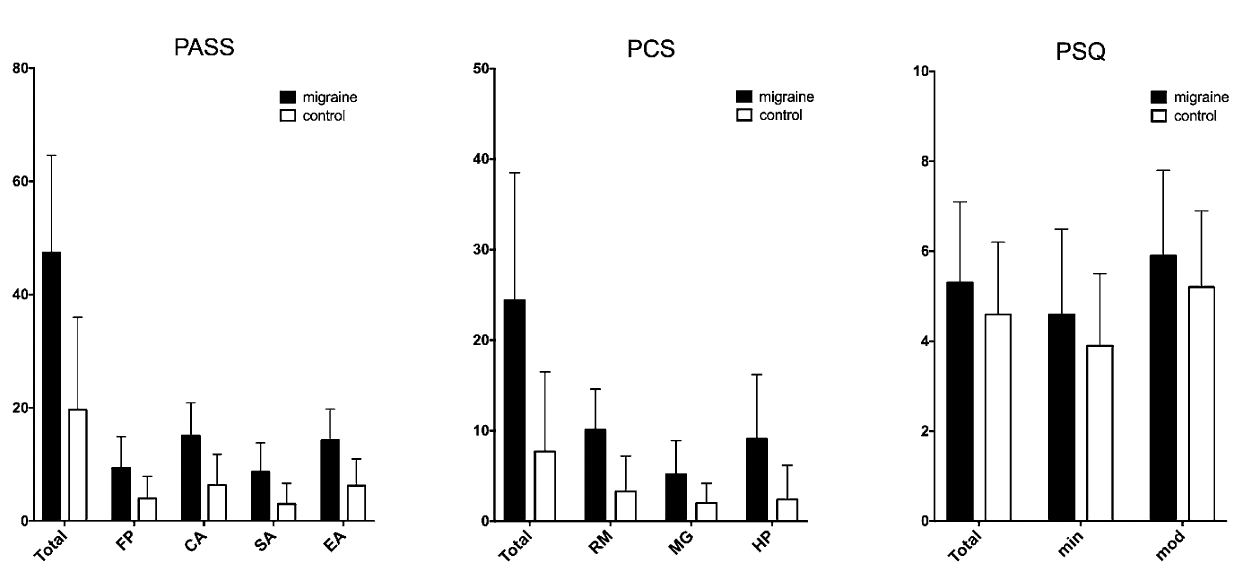
Figure 3. The graphs show a statistically significant difference in emotional factors of pain perception between migraine patients with migraine and healthy controls ( p <